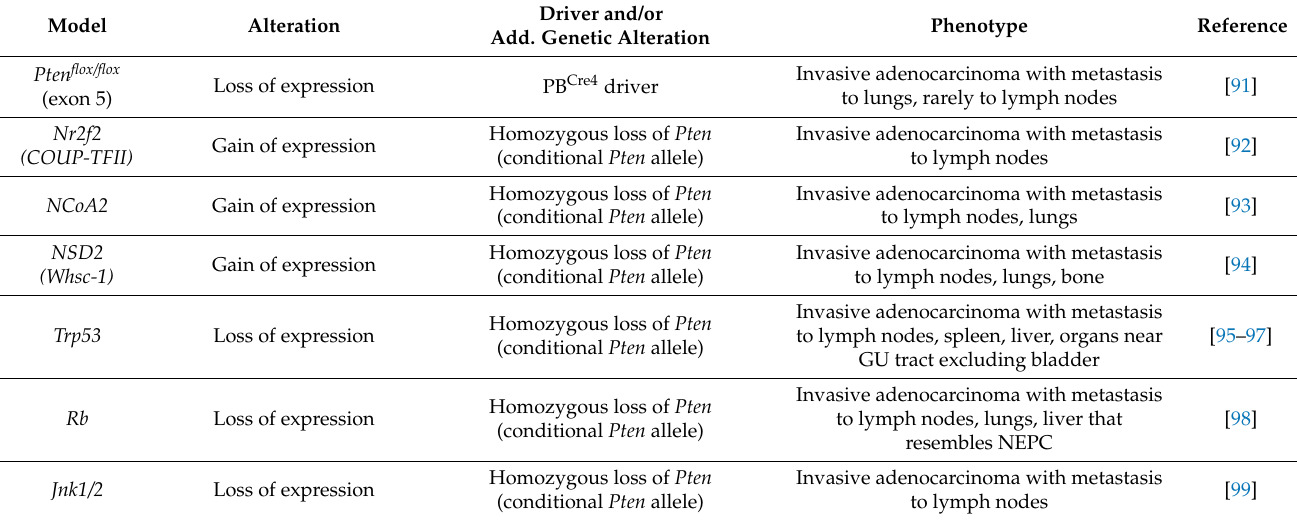
Table 7. PCa models in which metastasis is